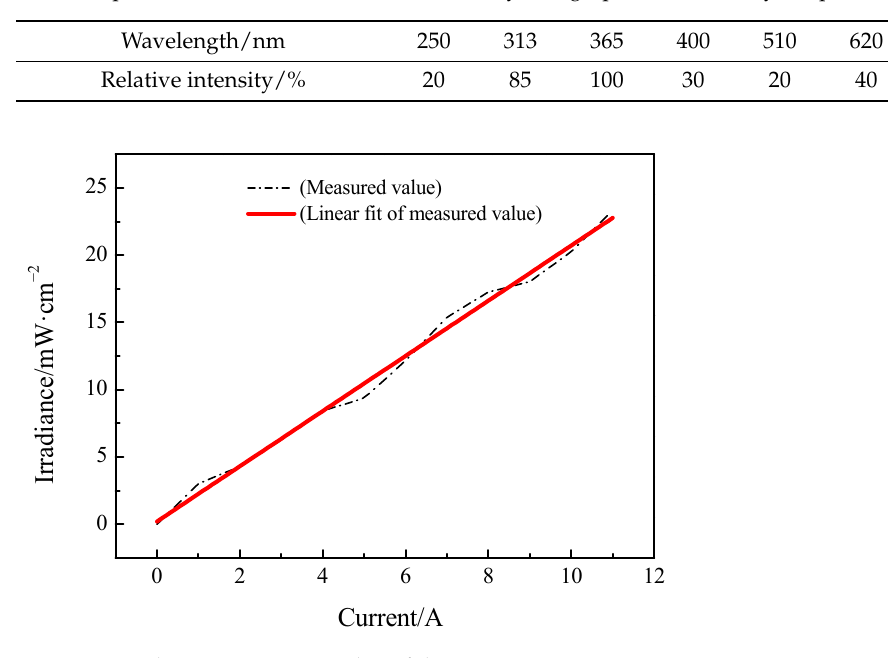
Figure 5. Irradiance vs. current value of device.